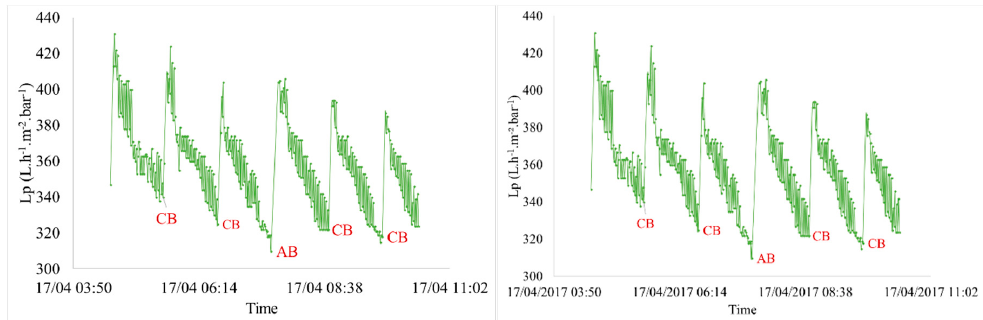
Figure 3. Variation of permeability vs. time (J = 60 L h − 1 m − 2 and t filtration = 60 min for seawater filtration)—Zoom on a 7-hour period.